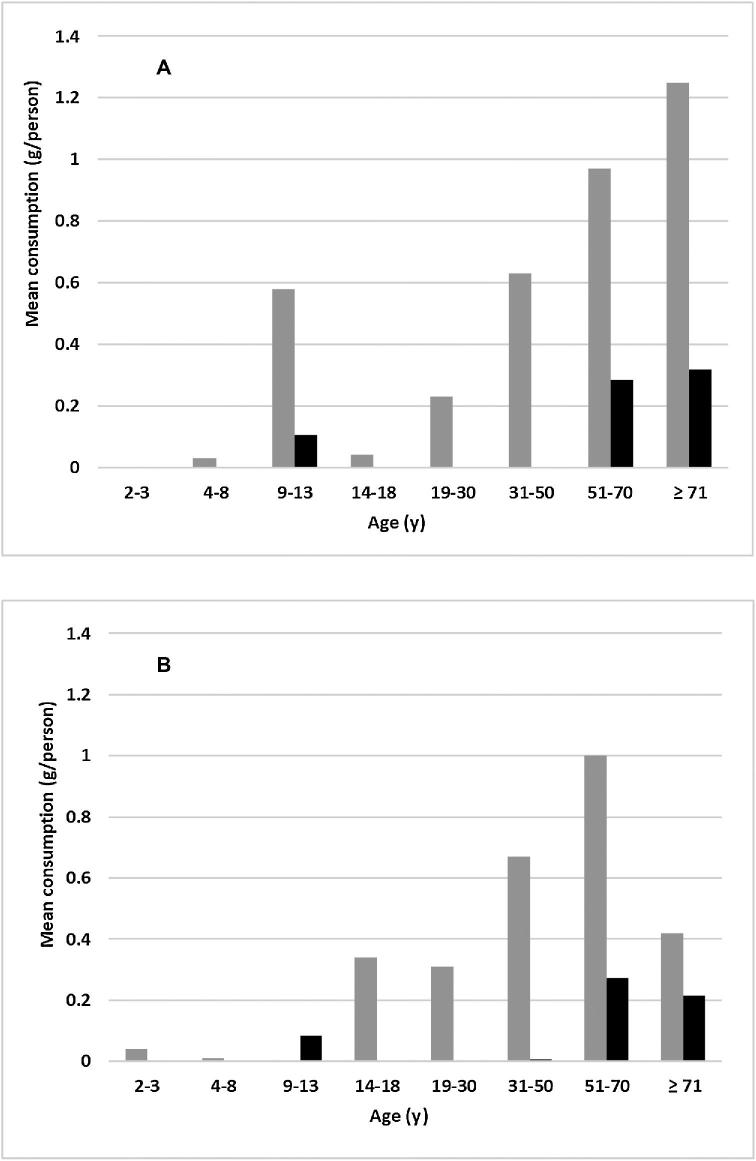
Mean liver consumption on the first day of the survey (grams per person) for all male (A) and female (B) respondents in 2 national Australian surveys. Grey columns: 1995 National Nutrition Survey; black columns: 2011–2012 National Nutrition and Physical Activity Survey.